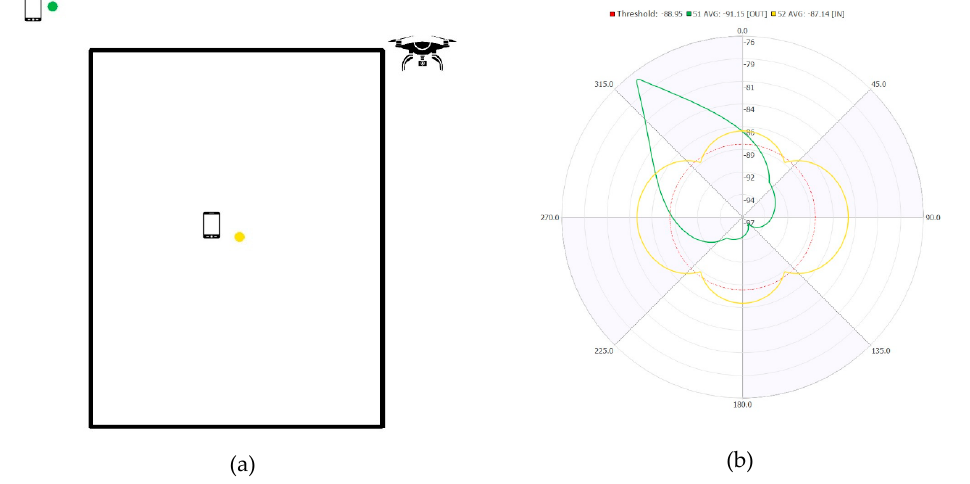
Figure 9. ( a ) i-th monitoring area; ( b ) Polar diagram of the measured power.